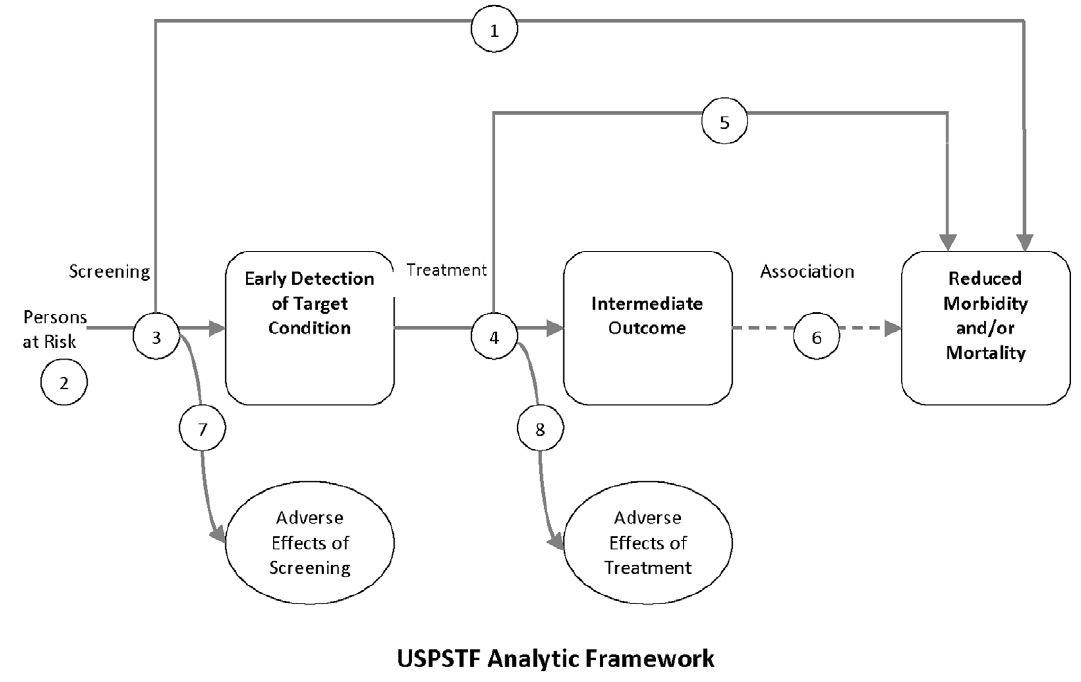
Figure 1. USPSTF Framework for Evaluating Screening Programs.